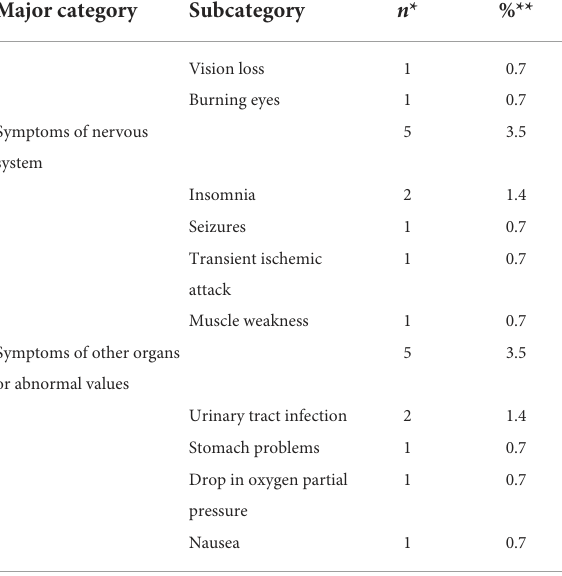
TABLE 2 Additional symptoms of patients with acute COVID-19 reported by